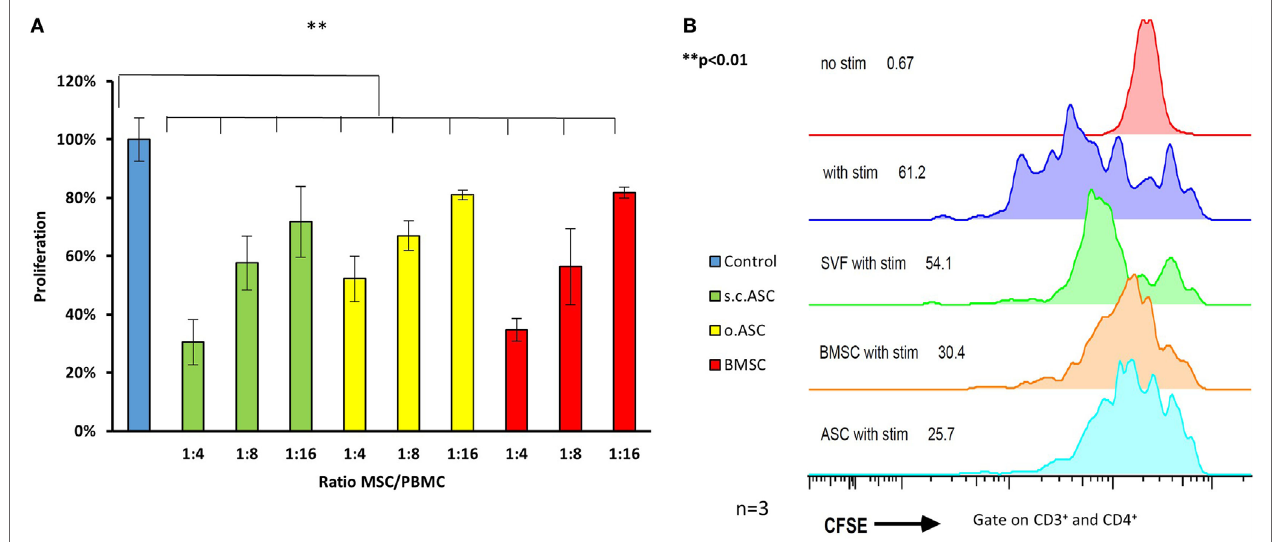
FigUre 3 | Ratios ranging from 4:1 to 16:1 between responder cells [peripheral blood mononuclear cells (PBMCs)] and mesenchymal stem cell (MSC) were added to proliferation assays ( n = 3 from three different human donors) stimulated with phytohemagglutinin (PHA) (a) . All three types of MSC show a dose depended reduction responder cell proliferation detected by H 3 thymidine assay, with the most effective inhibition by adipose-derived mesenchymal stem cell (ASC). Panel (B) shows representative results of a co-culture stimulated with PHA, gated on CD3 + and CD4 + cells confirming potent inhibition by ASC. Addition of stromal vascular fraction (SVF) cells at the same ratio resulted in a far weaker inhibition compared with cultured cells